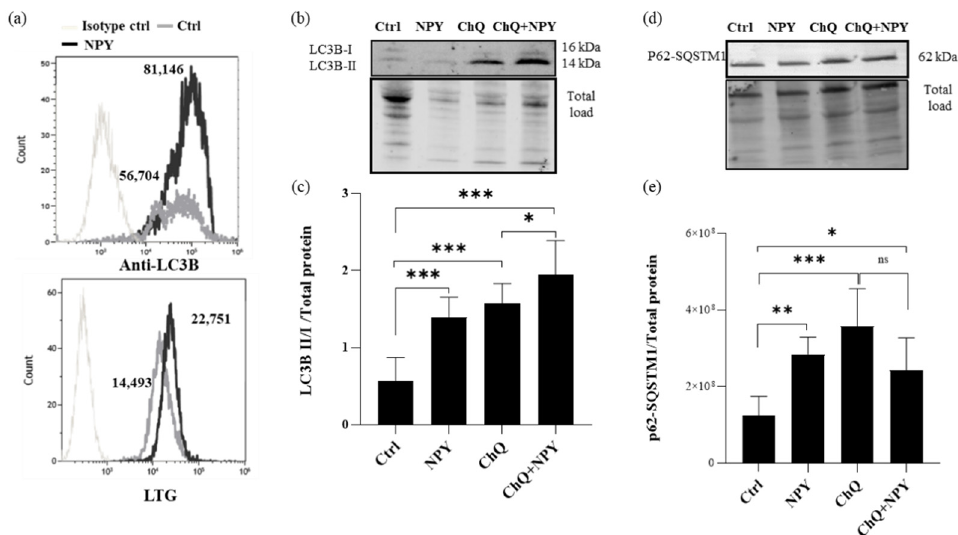
Figure 6. Flow cytometry and Western blotting analysis of autophagy markers in M0 macrophages treated with 10 − 8 M NPY for 24 h. ( a ) Representative flow cytometric analysis of autophagic marker LC3B and lysosomal dye LysoTracker (LTG) signals in M0 macrophages treated with 10 − 8 M NPY for 24 h. Cells were labeled with anti-LC3B-Alexa Fluor488 or isotype-Alexa Fluor488 or 10 µM LTG. Histogram overlays of LC3B or LTG expression of isotype control cells, untreated, and NPY-treated cells are shown. Median fluorescence intensity (MFI) values are indicated. ( b – e ) Western blotting analysis of LC3B and p62/SQSTM1 were performed in the whole-cell lysates of macrophages. Densitometric analysis of LC3BI/II panel ( c ) and p62/SQSTM1 ( e ) in M0 macrophages. Analyses were performed with ImageLab software (Biorad) and normalized to total protein. Data are expressed relative to the control total protein as mean ± SD of 6 independent experiments. Significance was determined by one-way ANOVA followed by Tukey’s post hoc analysis; *: p < 0.05, **: p < 0.01, ***: p < 0.001. Panel ( b ) and ( d ) show representative Western blotting results of LC3B and p62/SQSTM1, respectively.